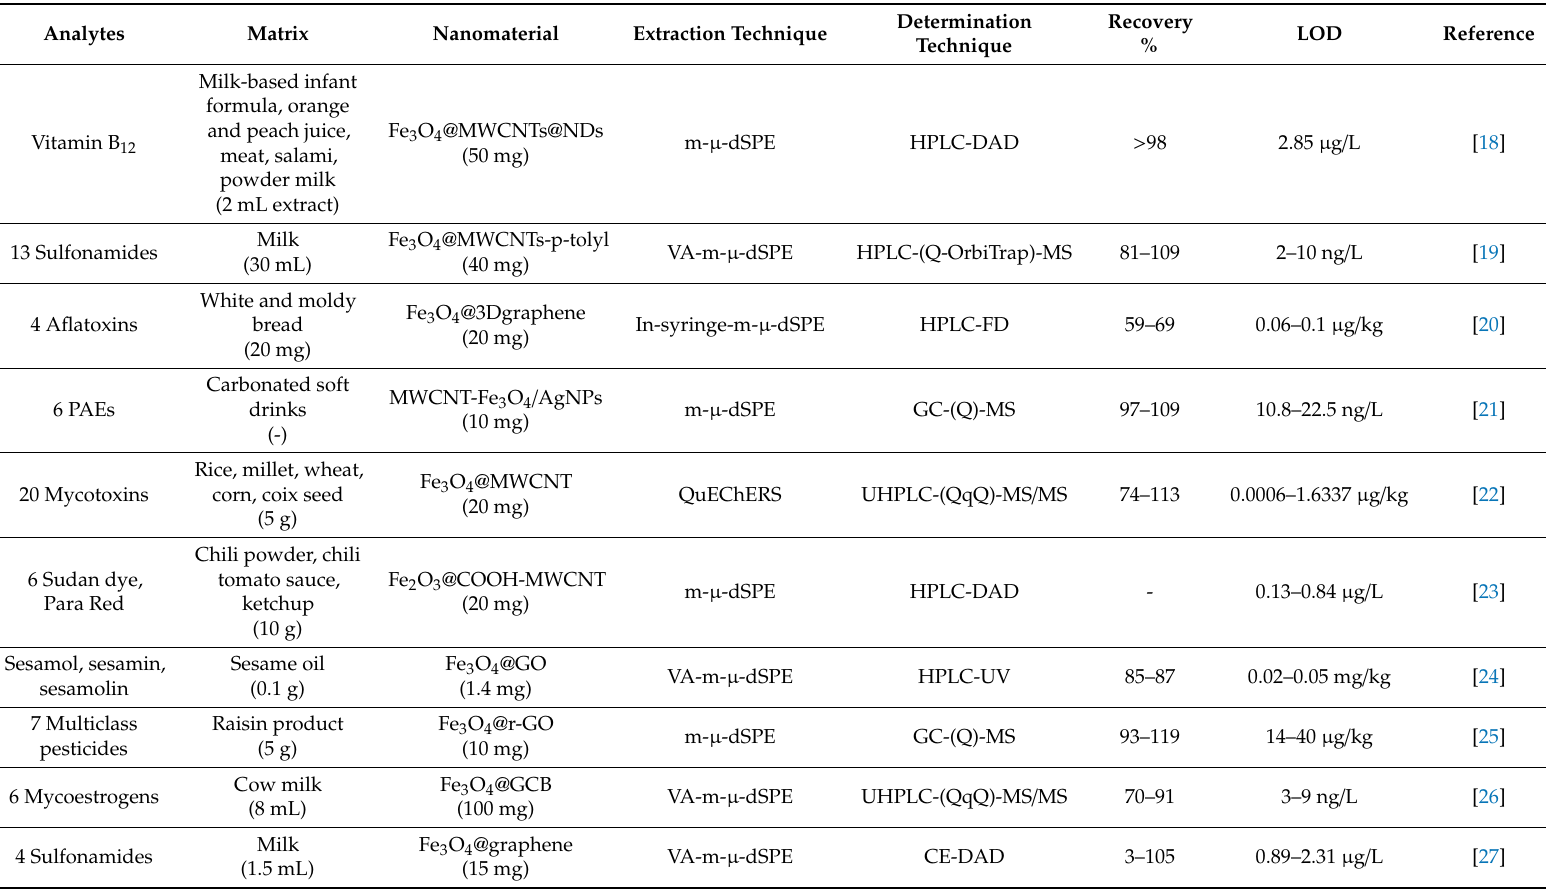
Table 1. Recent applications of magnetic carbonaceous nanomaterials as extraction sorbents in food